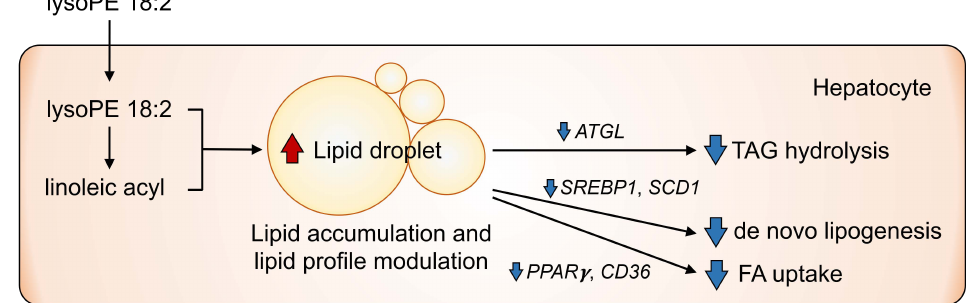
Figure 8. Putative effects of lysophosphatidylethanolamine (lysoPE) on hepatic lipid metabolism.